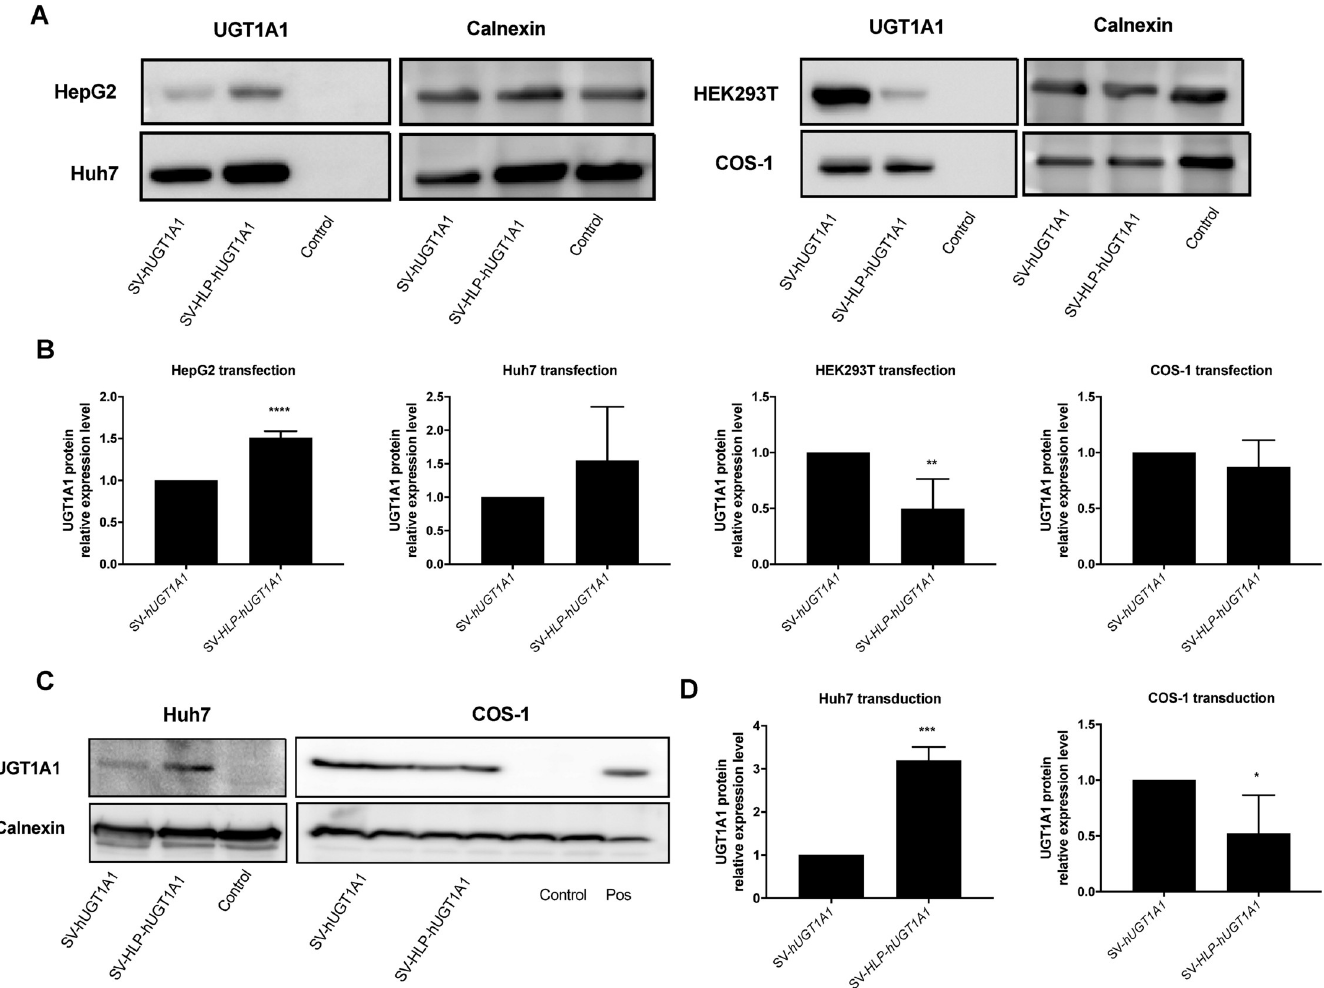
Fig 3. Insertion of a liver specific promoter in rSV40 provides specific expression of a therapeutic gene. (A) 10 5 cells of HepG2, Huh7, COS-1, or HEK293T cells were transfected with 1 μ g of rSV-h UGT1A1 or, rSV-HLP-h UGT1A . 48 hours later, UGT1A1 expression was determined by western blotting and quantified normalizing to calnexin, a membrane protein (B). (C) 10 5 cells of Huh7 and COS-1 cells were transduced with 400 vg/cell of rSV-h UGT1A or rSV-HLP-h UGT1A1 . After 2–5 days the cells were lysed and UGT1A1 expression was detected by western blotting and quantified by western blotting normalized to calnexin. All experiments were repeated 3–5 times. � p < 0.05, �� p < 0.01, ��� p < 0.001, ���� p < 0.0001. Data represent the mean ± SD. Statistical significance was determined by two- tailed Student t